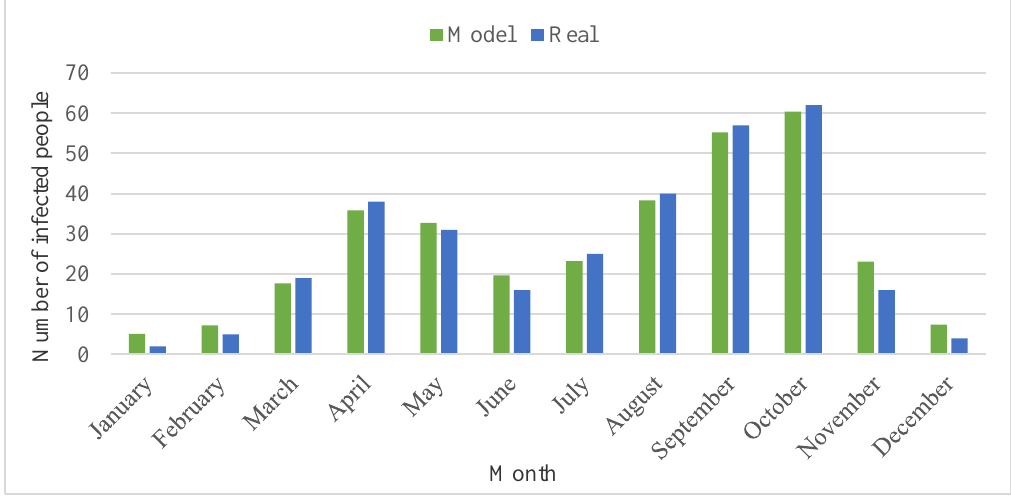
Figure 7. Comparison of the modeled and real observed numbers of infected people in the county of Sarbaz for each month in 2014.